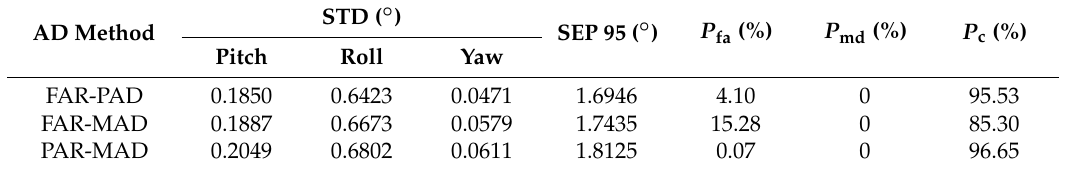
Table 3. Performance of ambiguity resolution and AD of three methods in the kinematic